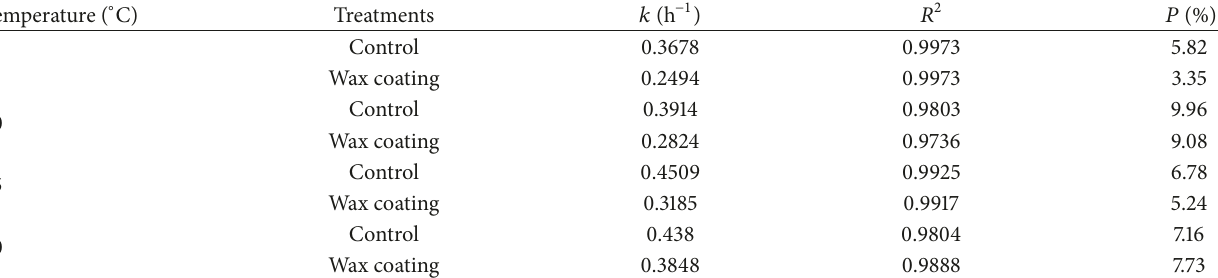
Table 1: The moisture loss rate constant ( 𝑘 ), correlation coefficient ( 𝑅 2 ), and the mean relative percentage deviation modulus ( 𝑃 %) in control and wax treated cucumbers at various temperatures.